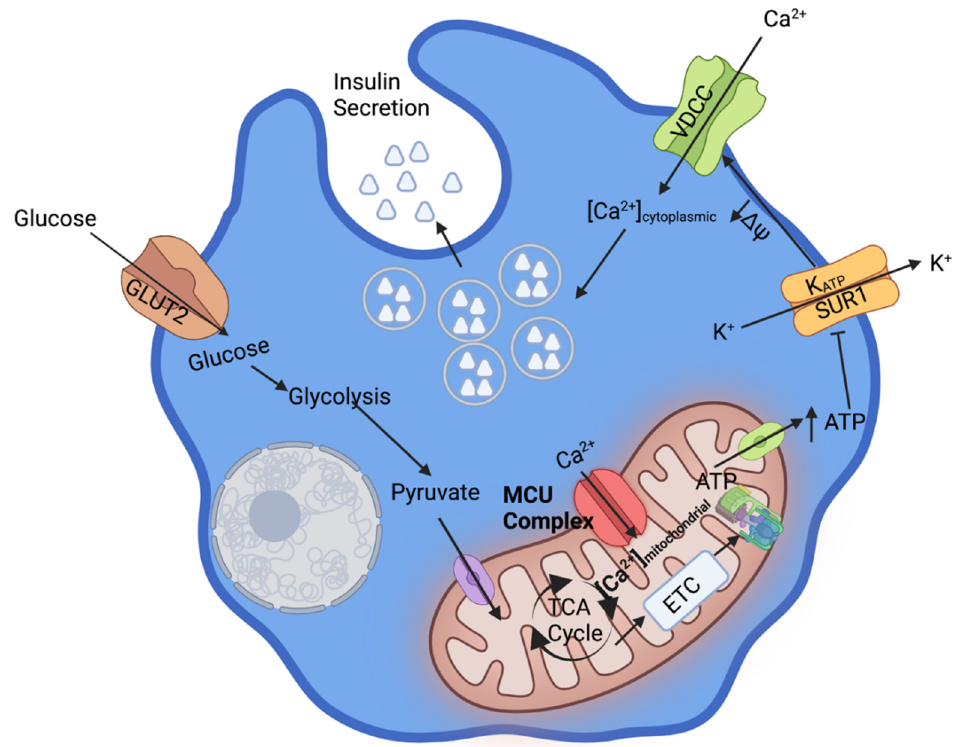
Figure 1. Mitochondrial Calcium Flux and GSIS in the Pancreatic β -cell. Under high blood glucose conditions, glucose enters the β -cell via the GLUT2 transporter. Glucose is then shunted to glycolysis, the TCA cycle, and the electron transport chain to generate ATP. ATP closes the K ATP channels, which results in insulin granule exocytosis. Ca 2+ is shunted to the mitochondria to further stimulate ATP production and cause continued insulin secretion. This figure was created with biorender.com.